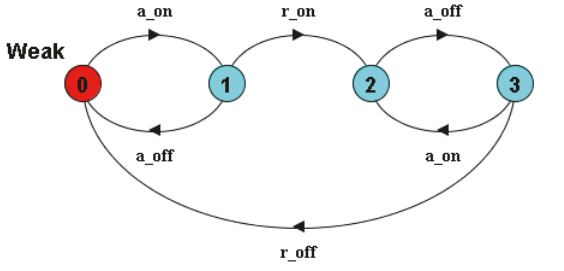
Figure 10: LTS model of weak synchronization pattern.